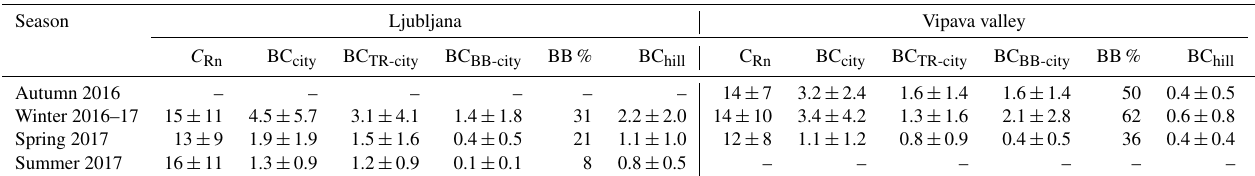
Table 4. Summary statistics (mean ± standard deviation) of measured Rn concentration (Bqm − 3 ), BC (µgm − 3 ) concentration apportioned to traffic and biomass burning for urban background sites in Ljubljana (ARSO) and Vipava valley (AJ), and BC (µgm − 3 ) concentration at the hill sites (GOL and OT).